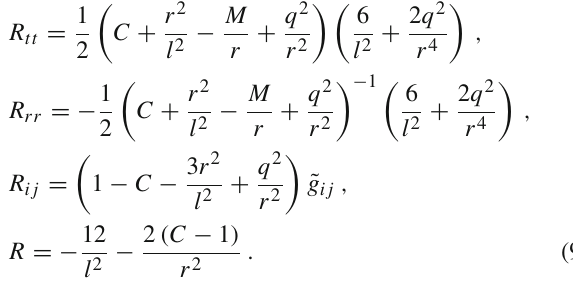
AB Fig. 17 The point B (cid:5) is identified with the point B . When C = 3 the light emitted at point A may reach point B = B (cid:5) along two different paths A > 1, the light emitted at point A ( ˜ φ = π and Fig. 18 When C = 5 4 ˜ r = r 0 , r 0 is a constant) cannot reach the shaded region (2 π = 2 C 5 2